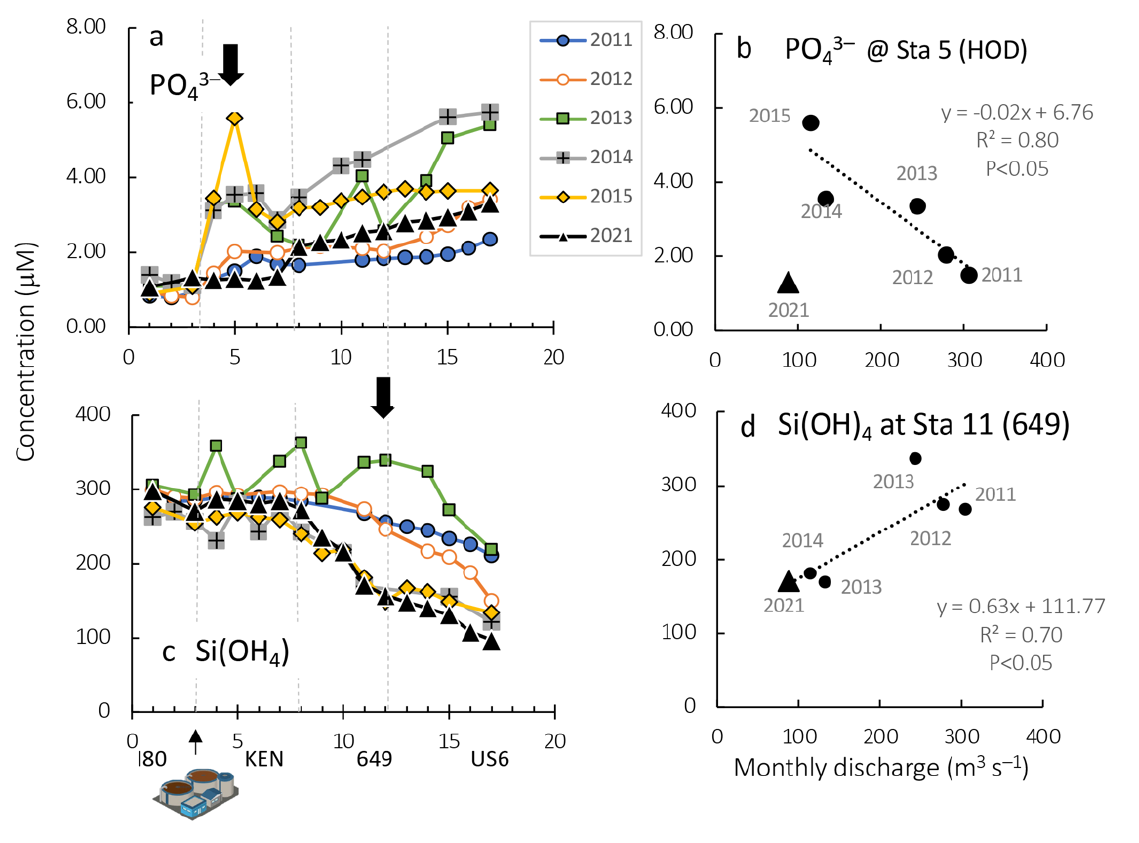
Figure 5. Transects of PO 43 − (panel a ) and Si(OH) 4 (panel c ) for the six years of sampling undertaken in the Bay Delta during September/October. Sampling in 2021 was 5 months after full implementation of the upgraded WWTP. Vertical dashed lines separate the major segments of the river/estuary. The WWTP icon shows location of discharge. Correlations of average monthly discharge and PO 43 − concentrations at station 5 (HOD), and Si(OH) 4 concentrations at station 11 (649) are shown in (panels b , d ), respectively. Note the stations for which relationships with discharge are shown are highlighted by black arrows in (panels a , c ). The 2021 data (highlighted as triangles) were not included in the PO 43 − regression.